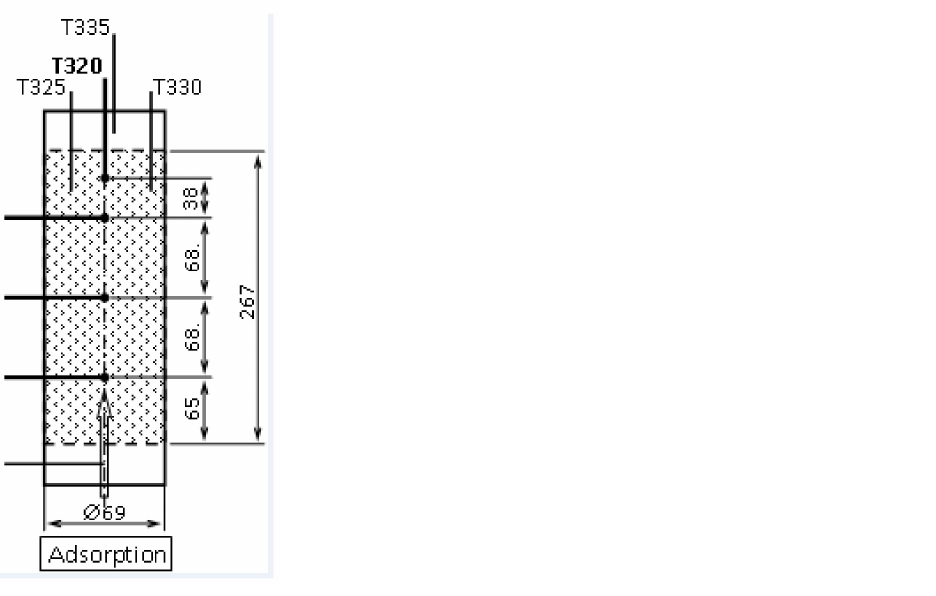
Figure 3. Schematic structure of the activated carbon filter with the thermocouples used (size indication in